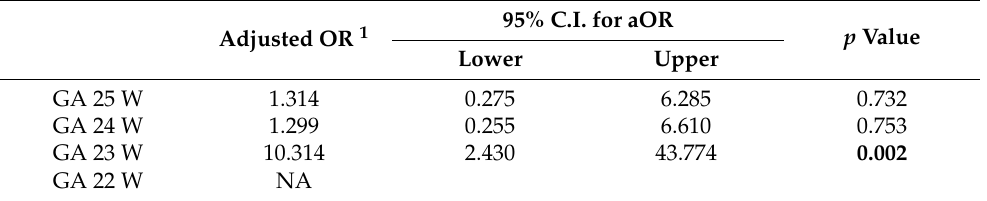
Table 4. Odds of survival of infants born in Epoch-II compared with Epoch-I in each gestational age group. Adjusted OR